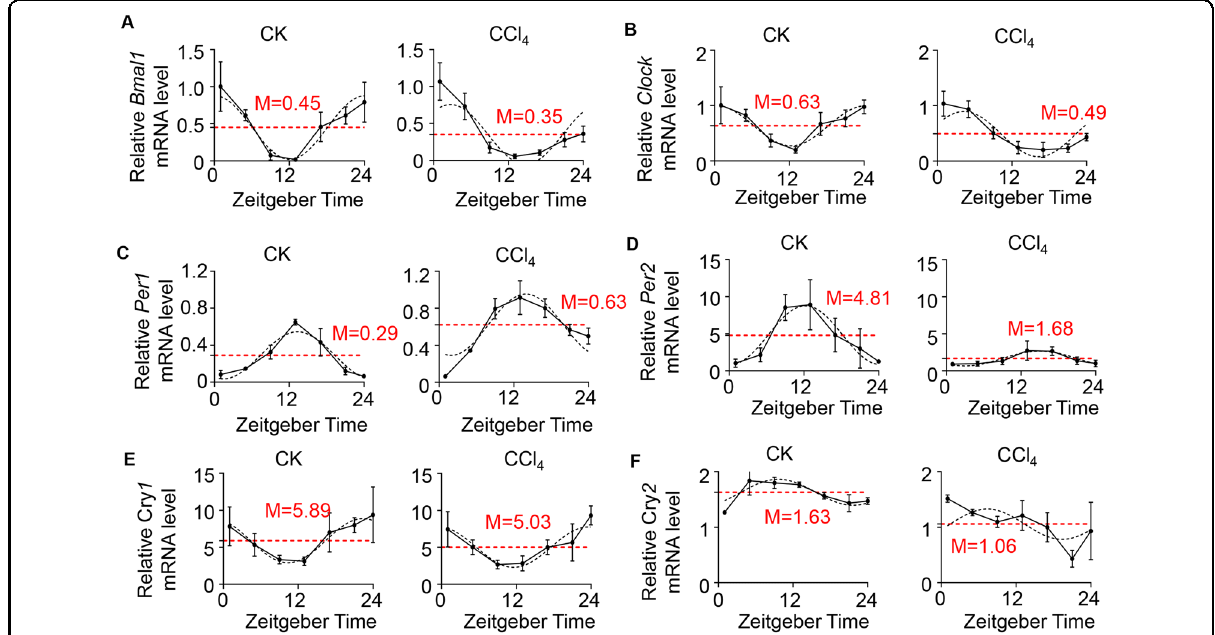
Fig. 2 Circadian expression of clock genes in control and CCl 4 -treated mice. A single intraperitoneal injection of CCl 4 (0.6 mL/kg body weight) was administrated to WT at ZT1. Mice were killed at ZT1, ZT5, ZT9, ZT13, ZT17, ZT21, and ZT24. Hepatic mRNA levels of Bmal1 A , Clock B , Per1 C , Per2 D , Cry1 E , and Cry2 F were measured by real-time PCR after CCl 4 treatment. CK: control. Solid lines indicate experimental response curves; dashed lines, fi tted model curves. Red dashed line with the number represents mesor. Data were shown as means ± S.E.M. N = 5 independent biological replicates per group. Data represent cumulative results from three independent experiments.